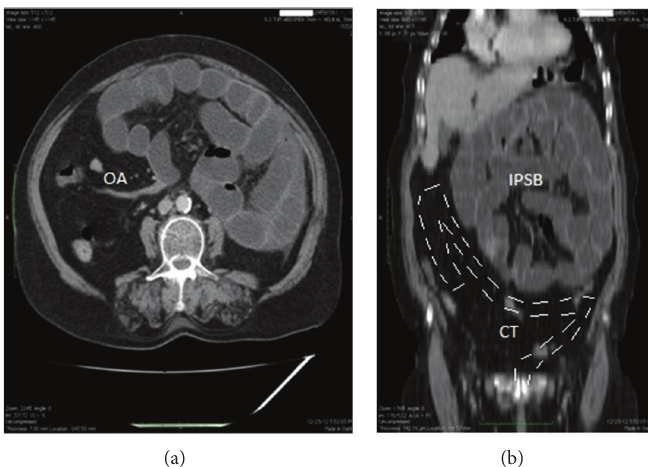
Figure 1: CT images demonstrating intestinal malrotation. On axial image (a), obstructed area (OA) indicates the obstructed part of terminal ileum. On coronal (b) image intraperitoneal small bowel (IPSB) is indicated in upper abdomen. Colon trace (CT) is oriented with (-) symbol.